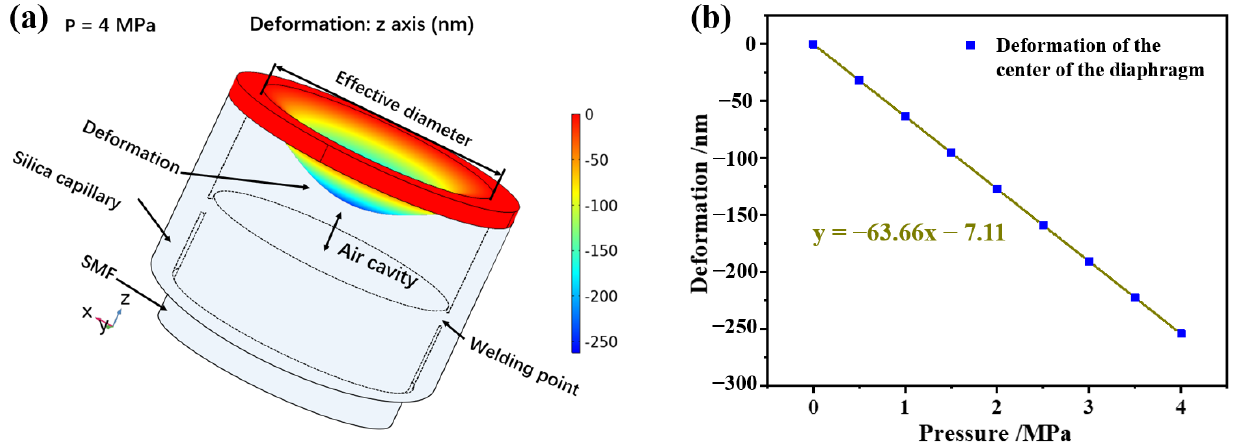
Figure 2. The physical model of the pressure senor. ( a ) The status of the pressure sensor under 4 MPa; ( b ) the deformation of the diaphragm center with pressure.